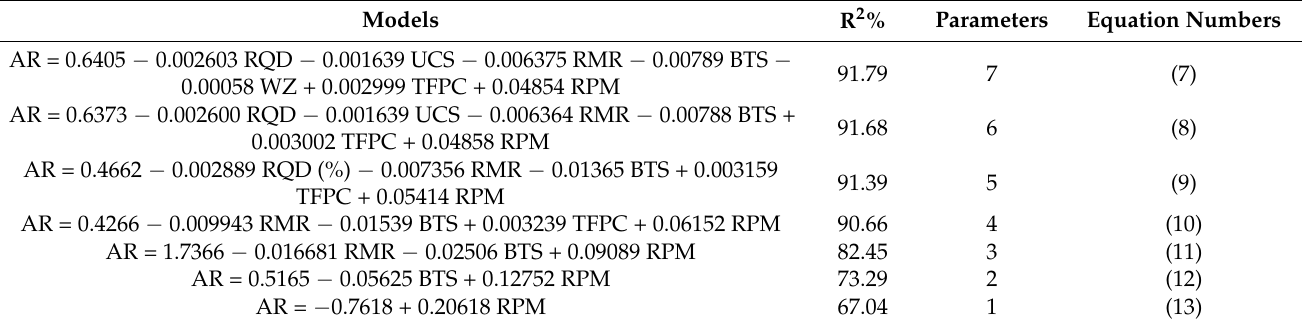
Table 10. Multiple linear regression equations with independent